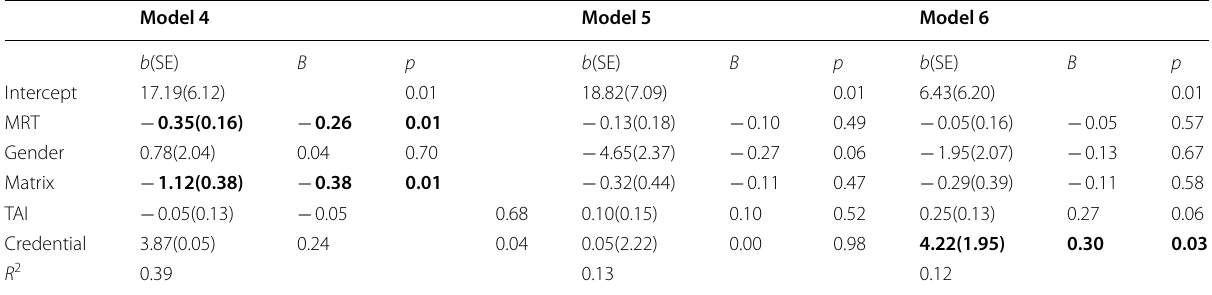
B are standardized betas. Numbers in parentheses are standard errors. “Matrix” denotes the ICAR Matrix Reasoning assessment. “TAI” denotes the Trait Anxiety Inventory. “Credential” is teachers’ reported type of credentialing. The outcome variables for Models 4, 5, and 6 are teachers’ Mental Manipulation subscale score, Imagery subscale score, and Navigation subscale score in that corresponding order. Significant input variables at the p < 0.05 level have been indicated in bold